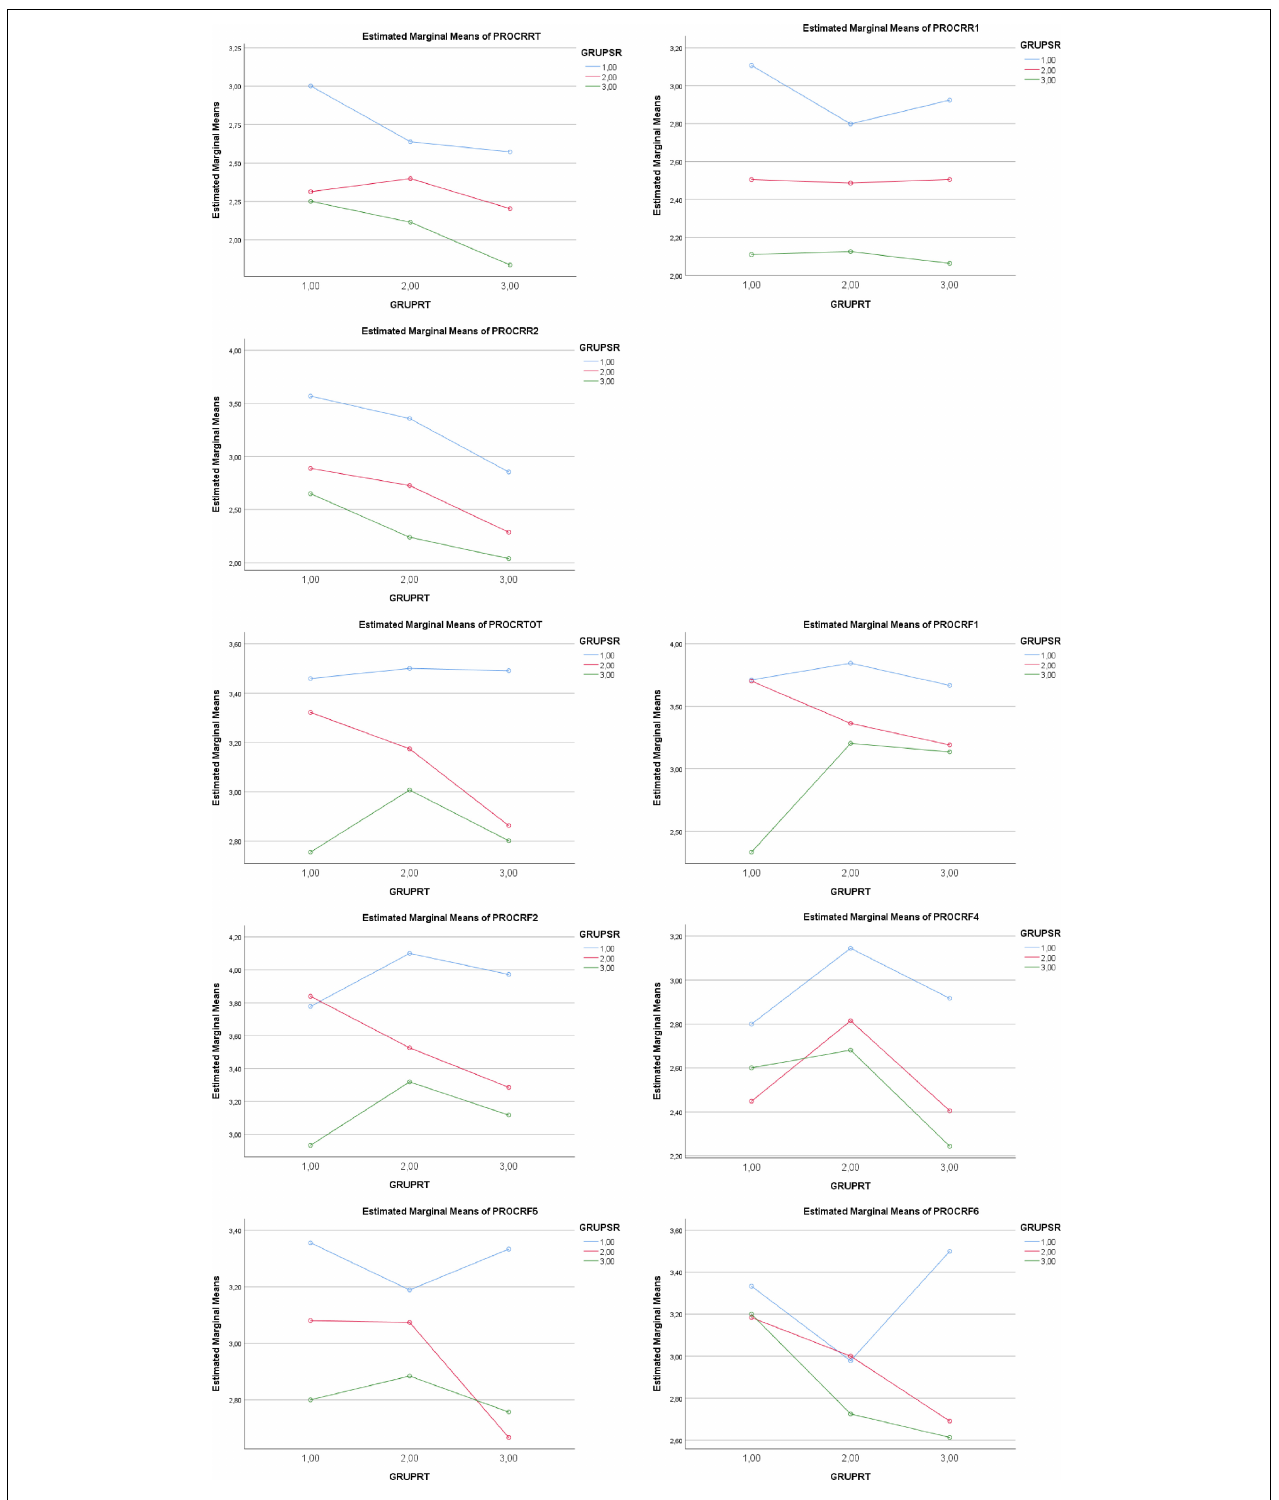
FIGURE 2 | Graphic representation of the effect of Self-Regulation level (GRUPSR) and Regulatory Teaching level (GRUPRT) on Reasons and Activities of Procrastination. PROCRF1, term papers; PROCRATF2, study for exams; PROCRATF3, assigned reading; PROCRATF4, admin. tasks; PROCRASTF5, attendance; PROCRATF6, activities in general. Reasons for procrastination: PROCRATOT, TOTAL; PROCRAR1, AROUSAL SEEKING; PROCRR2, LOW CONTROL; PROCRATR3, PERFECTIONISM.